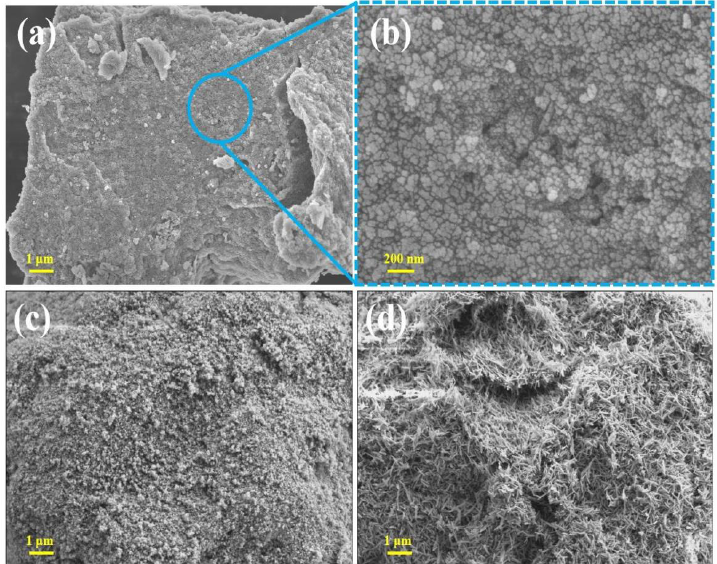
Figure 1. SEM images of ( a ) ferrihydrite, ( b ) ferrihydrite with a higher magnification, ( c ) hematite, and ( d ) goethite.